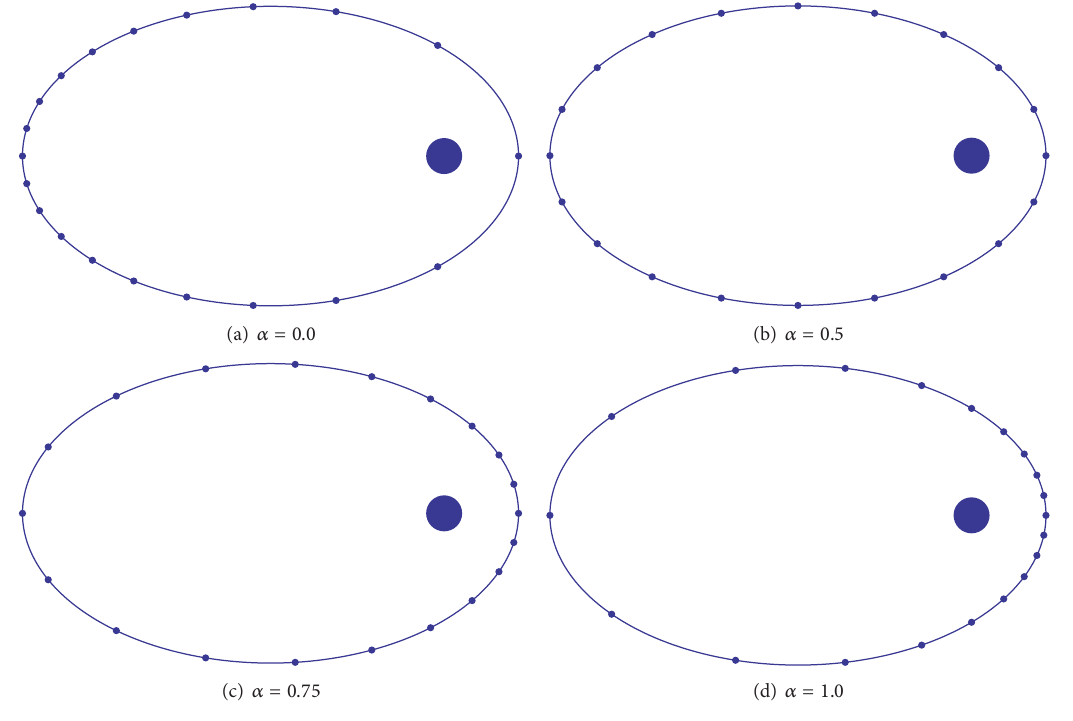
Figure 1: Points distribution for 𝑒 = 0.7 and 𝛼 = 0.0 , 0.5 , 0.75 , 1.0 . Table 1: Errors in position and velocity for HEOS I in 10 −5 Km and 10 −8 Km / s,